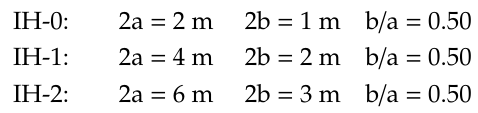
Figure 12. Influence of the geomechanical parameters of the rock, UCS and GSI, on the ultimate bearing capacity value when varying the load eccentricity. Detail between E/a = 0 and E/a = 2.